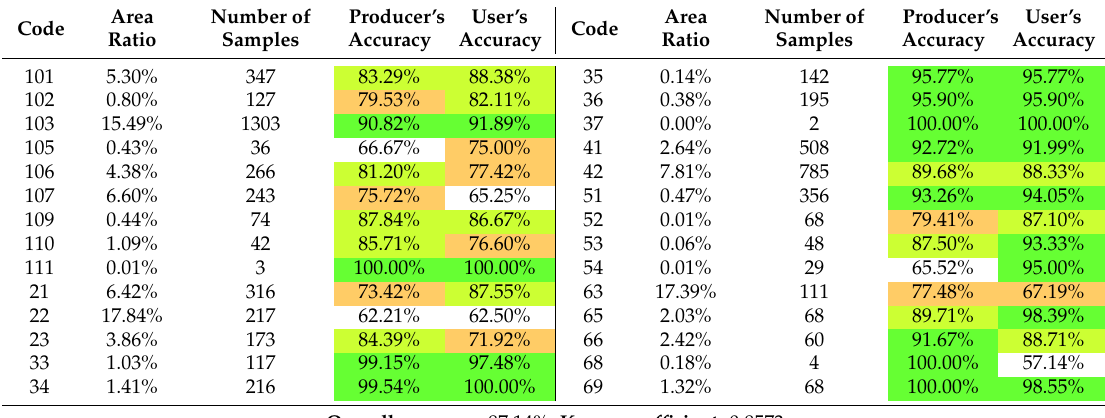
Table 5. The confusion matrix of secondary categories in the CLC-SW2010